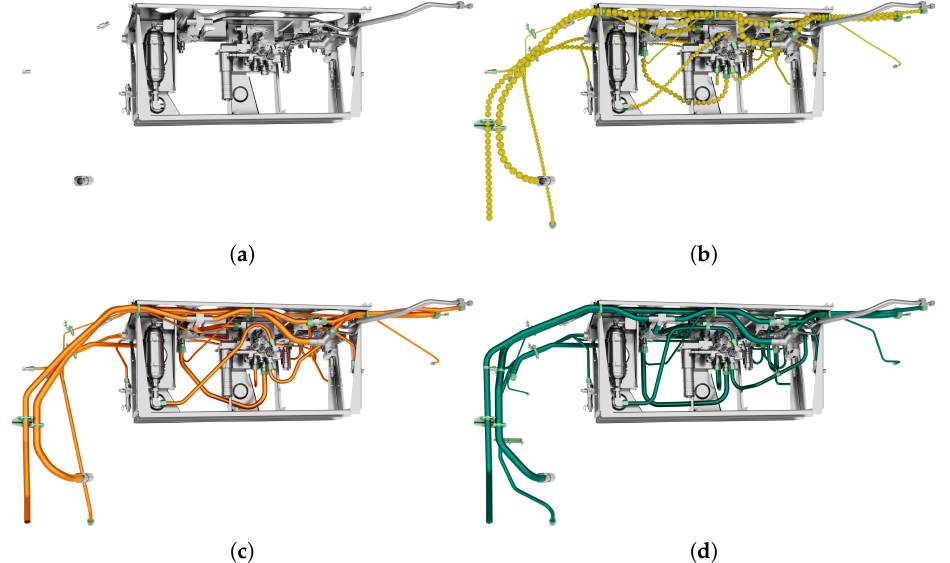
Figure 4. Exemplary installation space: Airbus A320 mounting rack. ( a ) Empty installation space, ( b ) Paths through the installation space, ( c ) Automatically generated pipes, ( d ) Manually designed pipes.